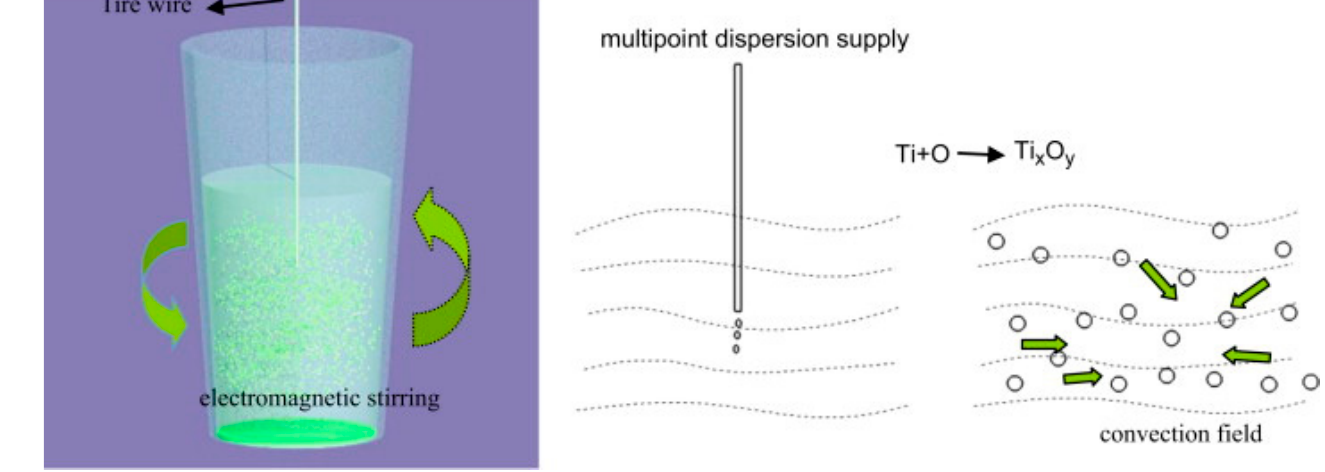
Figure 1. Schematic of the processing method for the formation of nanoparticles in melt through a combination of multipoint dispersion supply method and electromagnetic stirring, reprinted with permission from ref. [64], 2022, Elsevier.